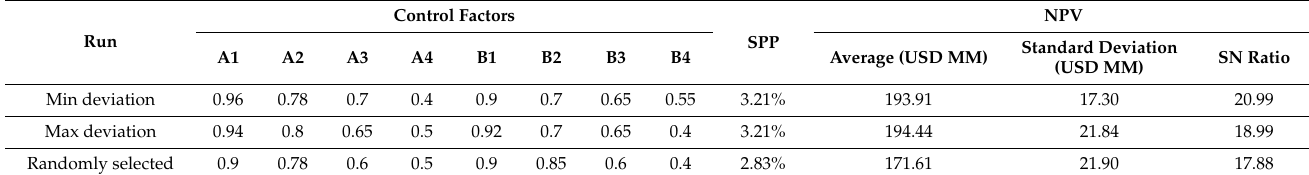
Table 9. Comparison between a randomly selected run and two runs of the selected